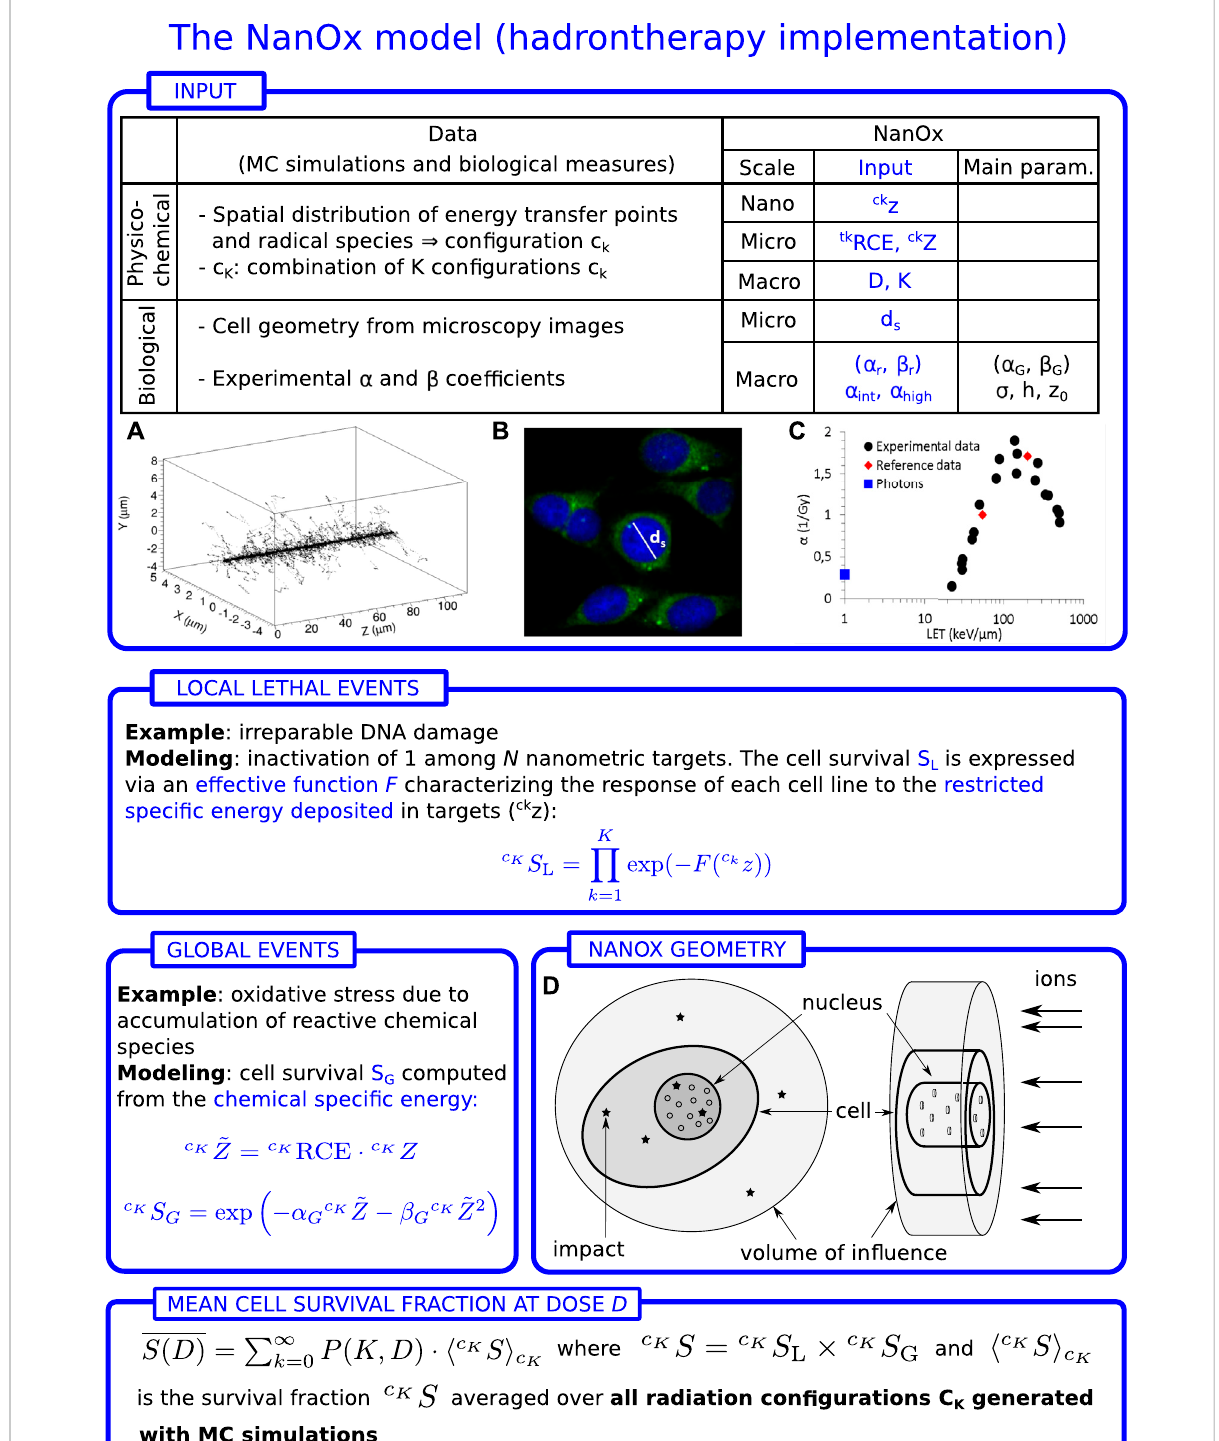
FIGURE 2 Work fl ow of the NanOx model for hadrontherapy. z and Z are the restricted speci fi c energies in the local targets and in the sensitive volume, respectively. D : macroscopic absorbed dose; K : number of impacts in the volume of in fl uence (volume large enough that the impact of a particle outside this volume leads to a negligible energy transfer into the sensitive volume); d s : average diameter of the cell nucleus; α r , β r : linear-quadratic (LQ) coef fi cients for reference radiation; α int , α high : linear coef fi cient for intermediate- and high-LET radiation, respectively; F ( z ): effective local